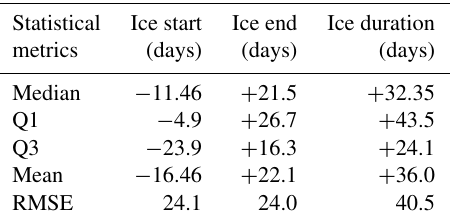
Table 2. Statistical metrics (simulations – observations) of the lake ice phenology (ice start, end and duration) obtained in the CJR3med